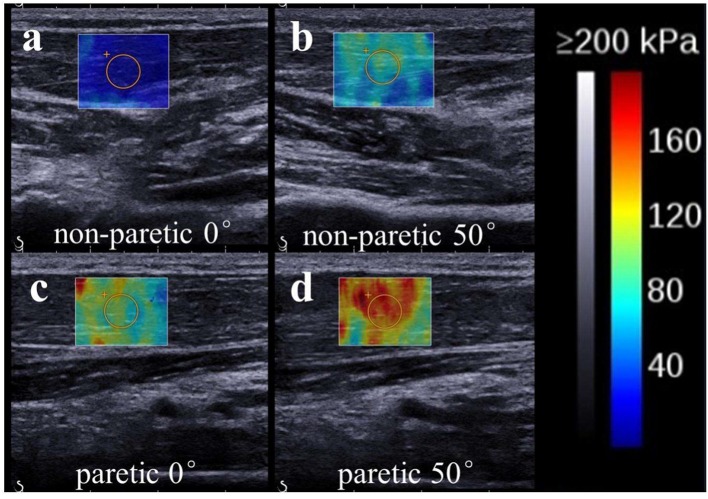
Representative ultrasound images (SWE ultrasound map superimposed on the B-mode image) of the non-paretic (a:0°; b:50°) and paretic (c:0°; d:50°) flexor carpi radialis. The value of shear wave modulus is greater in the paretic limb. We found the non-paretic muscle has a lower value of shear elastic modulus than the paretic muscle at the same wrist angle. Meanwhile, non-paretic and paretic muscle both has a lower value of shear elastic modulus when wrist was held at 0° than wrist was passive stretched at 50°.